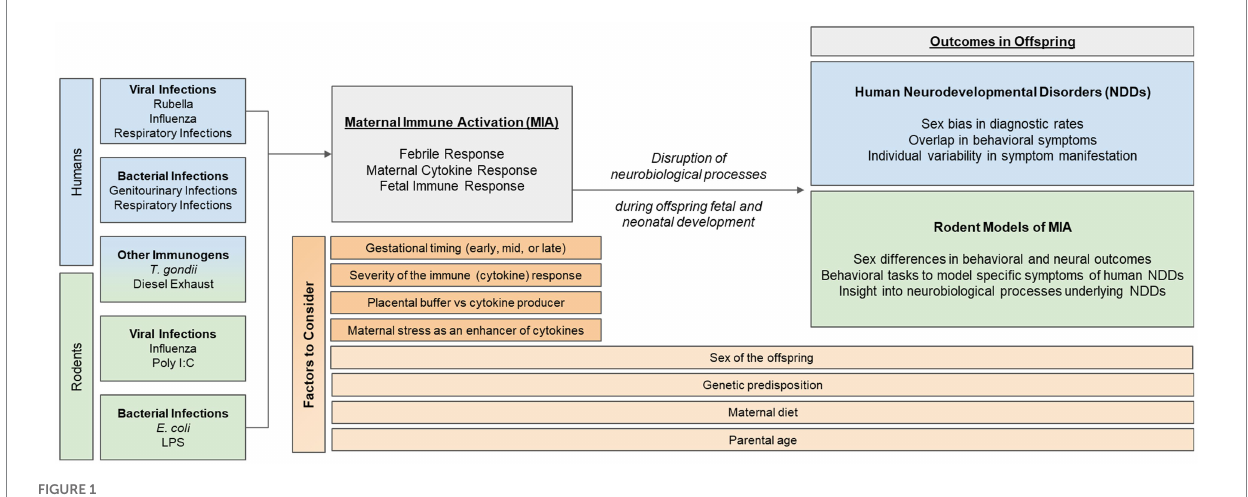
FIGURE 1 Proposed model of the association between maternal immune activation (MIA) and neurodevelopmental disorders (NDDs). Blue boxes represent human pathogens and outcomes related to MIA. Green boxes represent rodent immunogens and outcomes related to MIA. Orange boxes represent factors that should be considered in rodent models of MIA and their relevance for human NDDs. Dark orange boxes represent factors that are related to the gestational immune response, whereas light orange boxes represent factors that are related to the immune response both during gestation and in postnatal